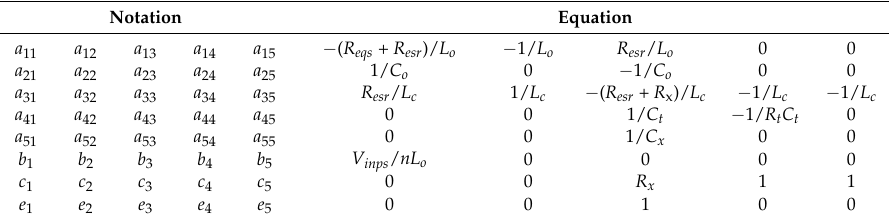
Figure 5. PSFB-PCDR equivalent model. ( a ) Three-terminal switch (TTS) model. ( b ) TTS model combines the wire resistance-inductance and the PNGV battery model. ( c ) Final equivalent circuit. Table 6. Element calculations for matrices A , B , C , and E .